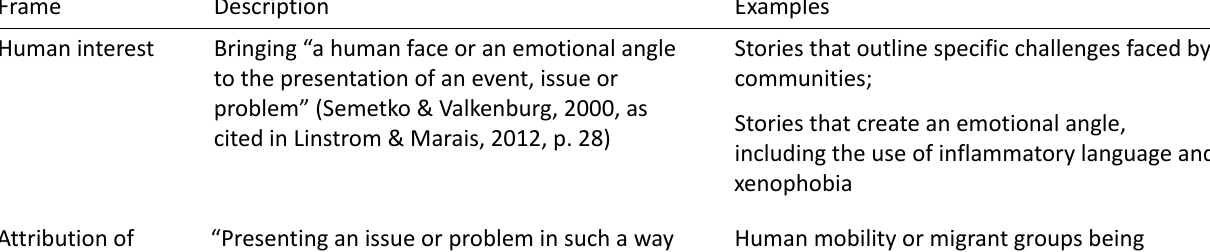
Table 1. Overview of the six frames